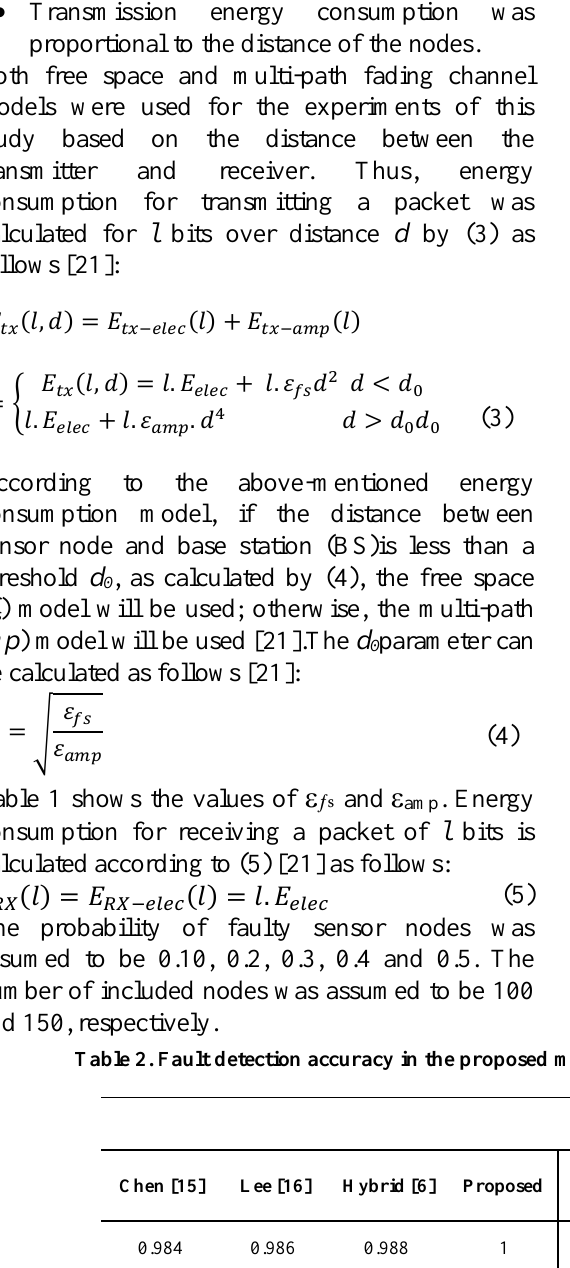
Table 1. Simulation parameters.